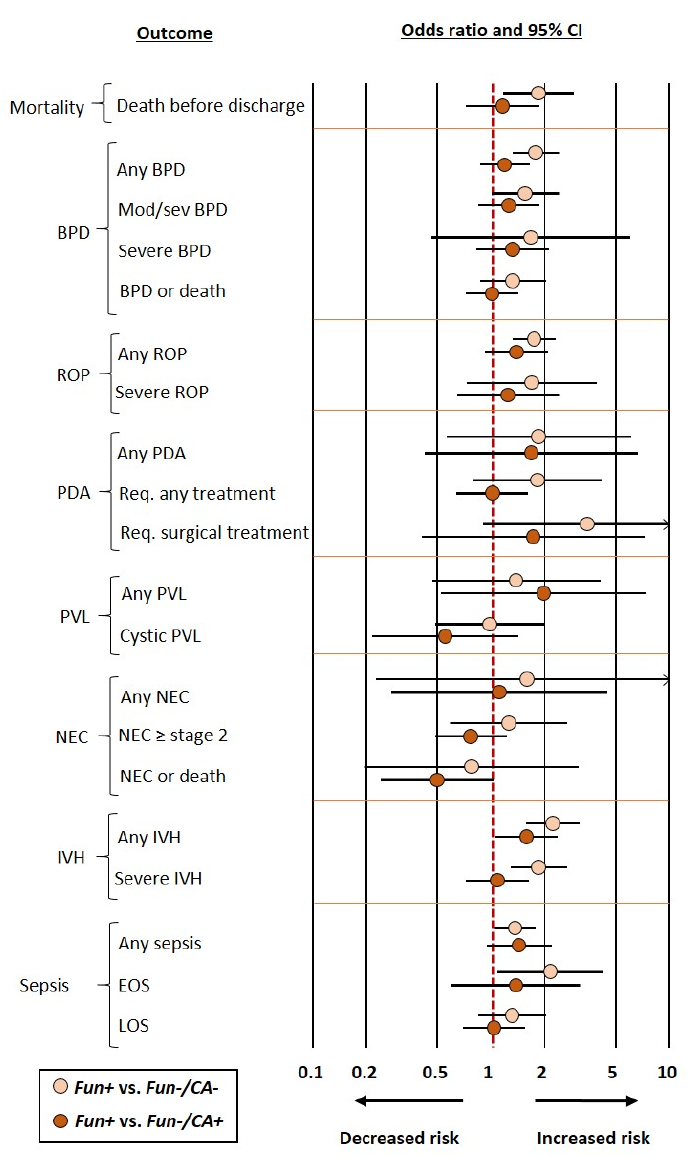
Figure 2. Summary of frequentist random-effects meta-analyses comparing infants with funisitis (Fun+) vs. infants who had neither funisitis nor chorioamnionitis (Fun − /CA − ) or infants without funisitis but with chorioamnionitis (Fun − /CA+). BPD: bronchopulmonary dysplasia; EOS: early-onset sepsis; IVH: intraventricular hemorrhage; K: number of studies included in the meta-analysis; LOS: late-onset sepsis; NEC: necrotizing enterocolitis; PDA: patent ductus arteriosus; PVL: periventricular leukomalacia; Req.: requiring, ROP: retinopathy of prematurity.